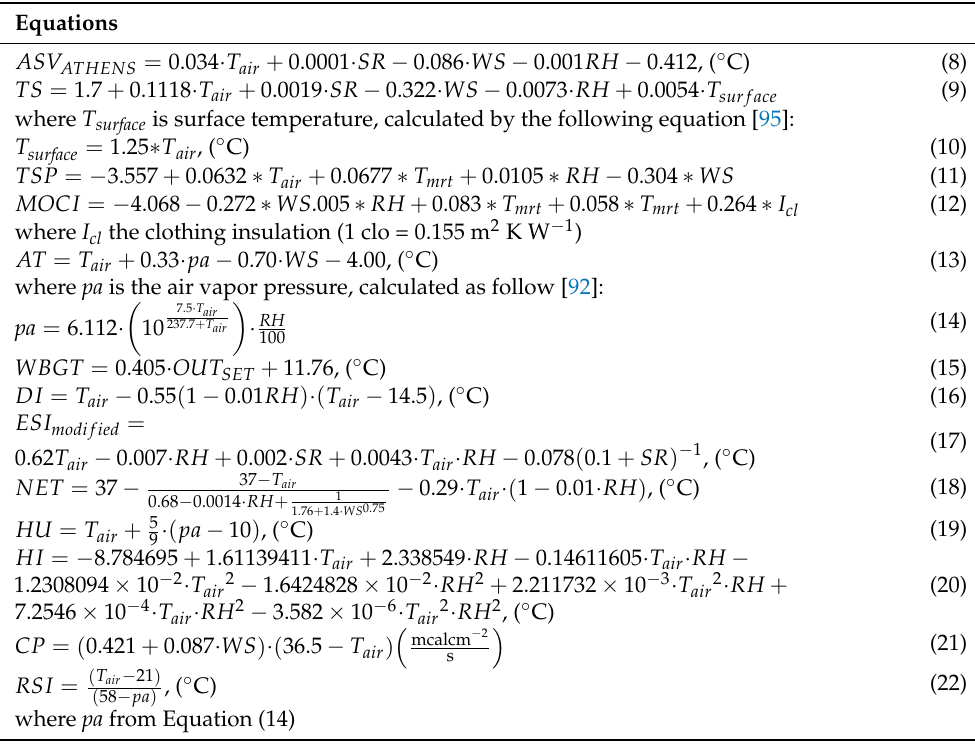
Table 5. Indices calculated in the study.